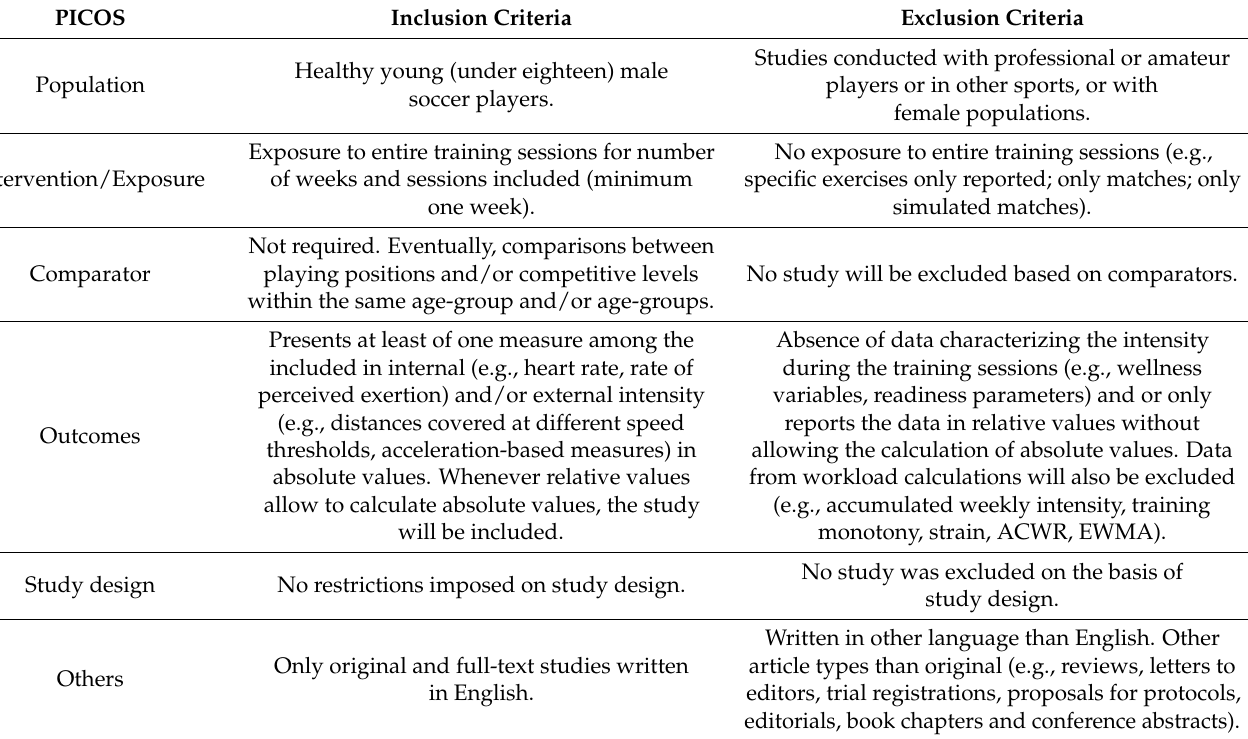
Table 1. Eligibility